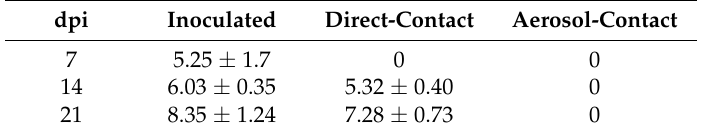
Table 7. Results of antibody titers of guinea pigs after inoculating rSD01-PA a (log2 ± SD, n = 5).